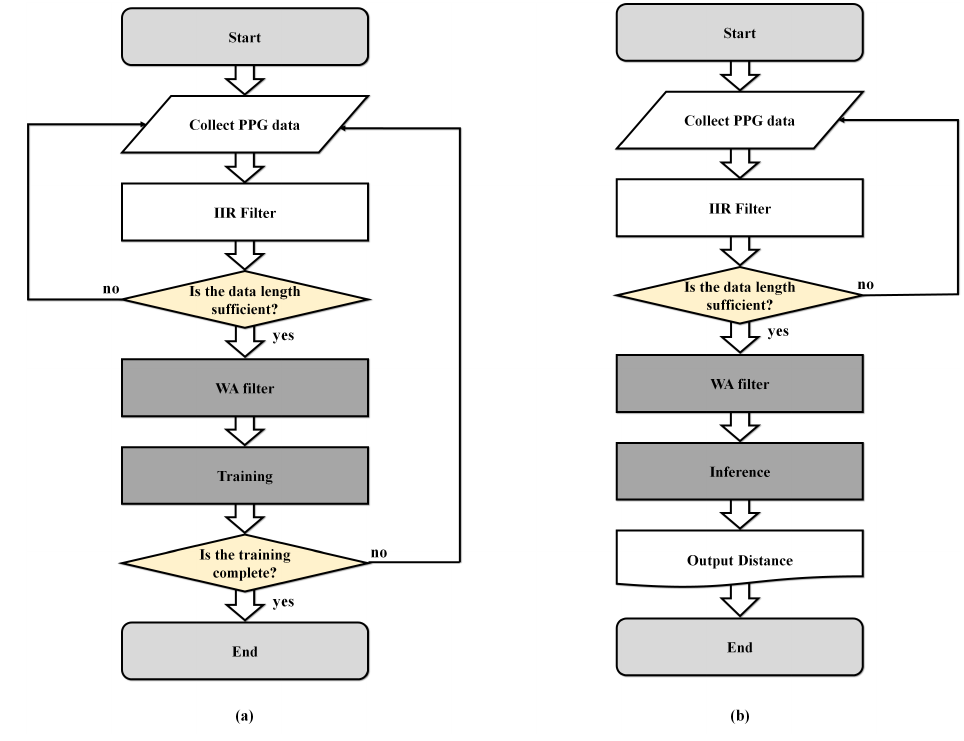
Figure 6. ( a ) Flow chart for training; ( b ) Flow chart for